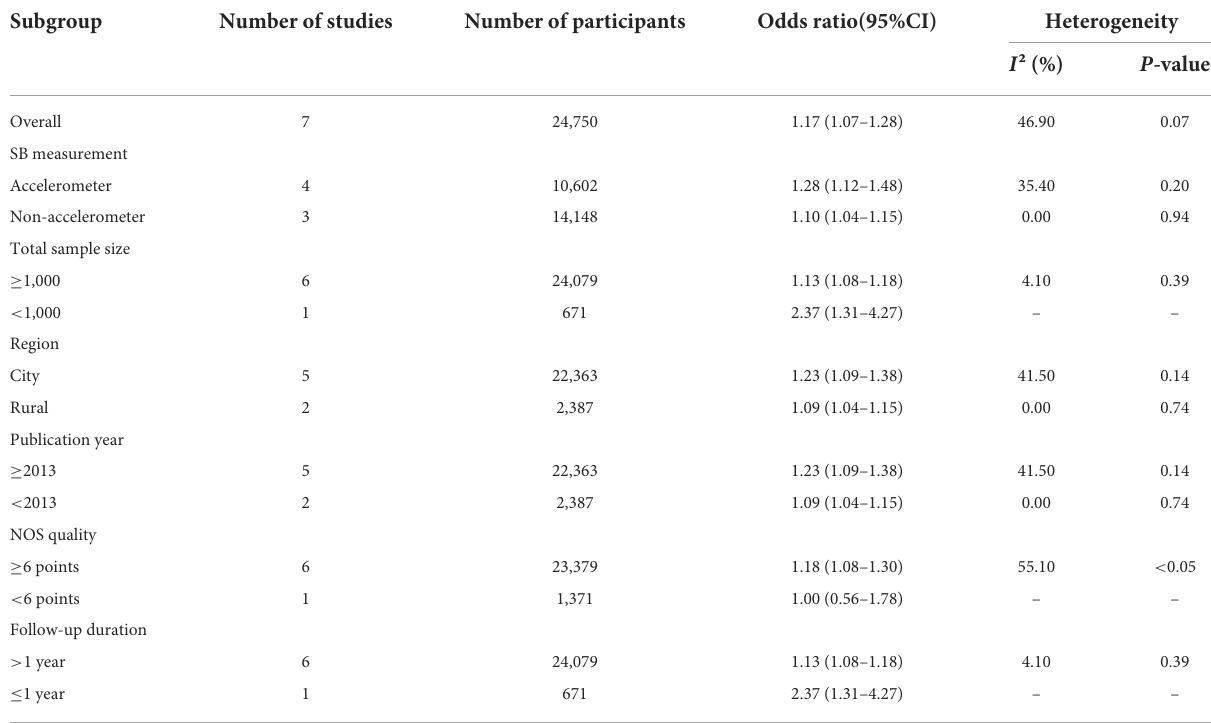
TABLE 2 Primary results and subgroup analyses based on random effect